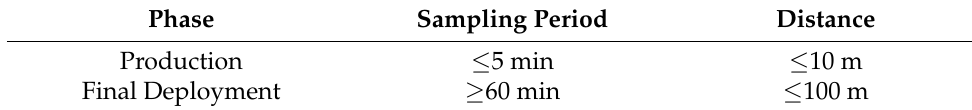
Figure 4. Sensor data transmission in the artifact final deployment phase. Table 1. Transmission requirements for the two operational